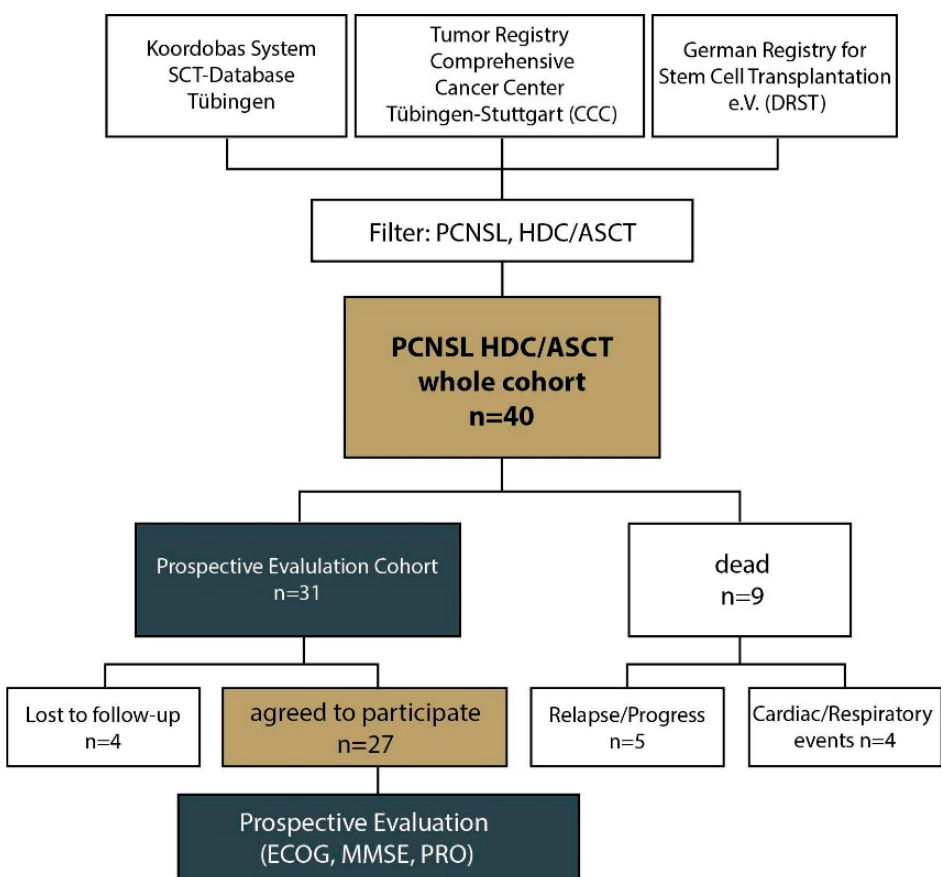
Figure 1. Study workflow. By screening the CCC, the Koordobas and the DRST databases using the diagnosis primary central nervous system lymphoma (PCNSL) in conjunction with